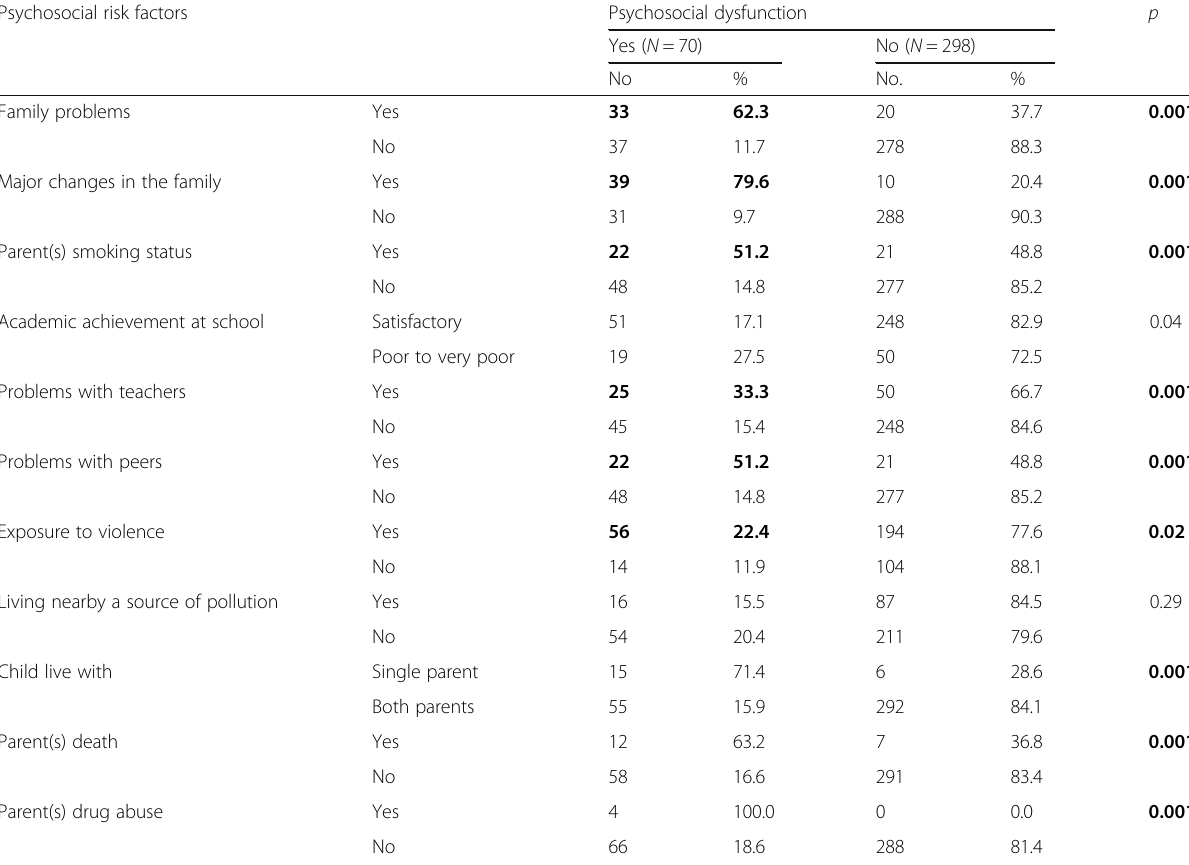
Table 6 Association between psychosocial risk factors and CPD Psychosocial risk factors Psychosocial